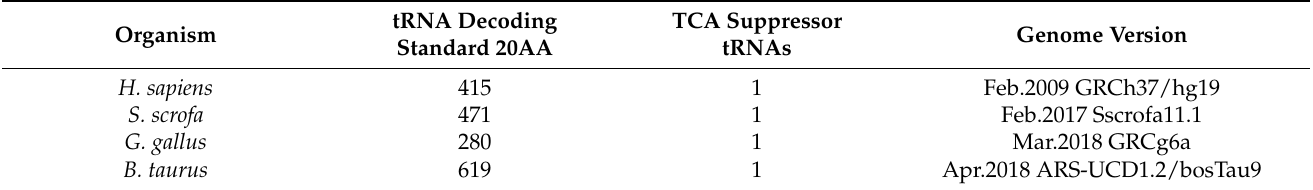
Table 5. tRNA Gene Summary of Homo sapiens , Sus scrofa , Gallus gallus, and Bos taurus on GtRNAdb v2 (accessed on 9 April 2022).